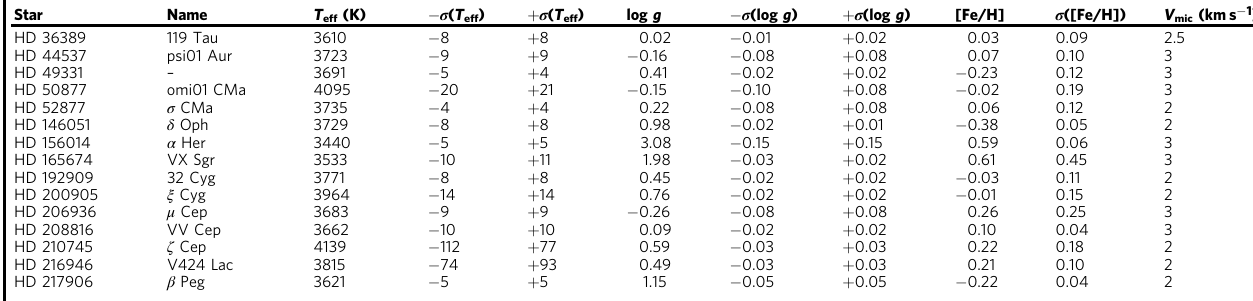
Table 2 Physical parameters of red supergiants obtained in this study. Star